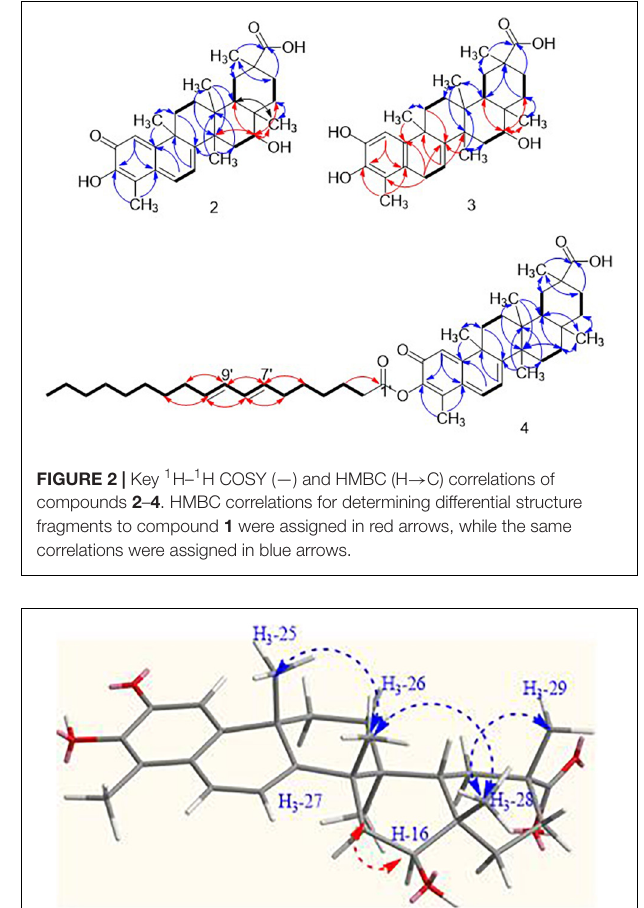
FIGURE 3 | NOESY correlations (H ↔ H) of 2